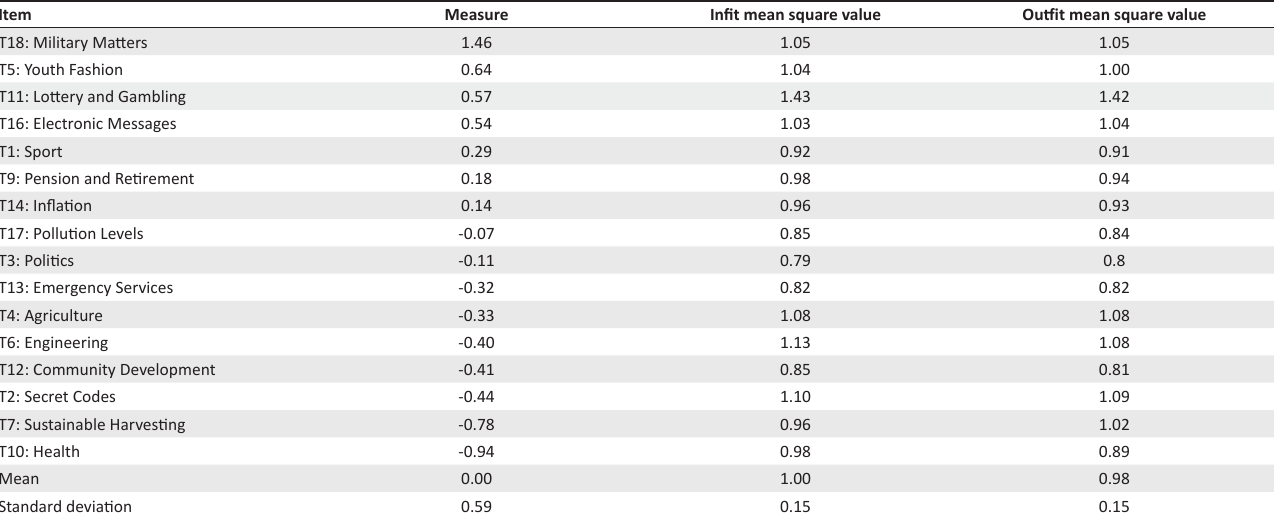
TABLE 2: Measure and fit statistics.